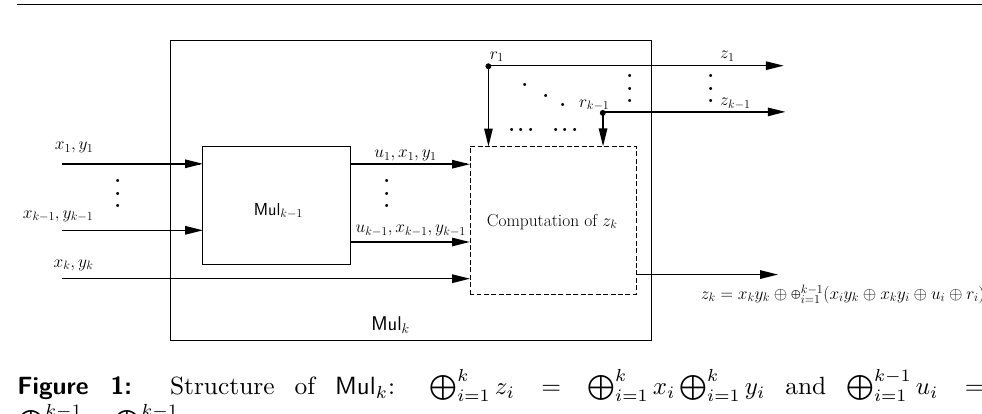
Figure 1: Structure of Mul k